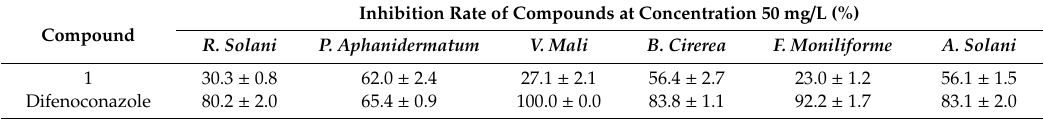
Table 6. The in vitro antifungal activity of Compound 1 .